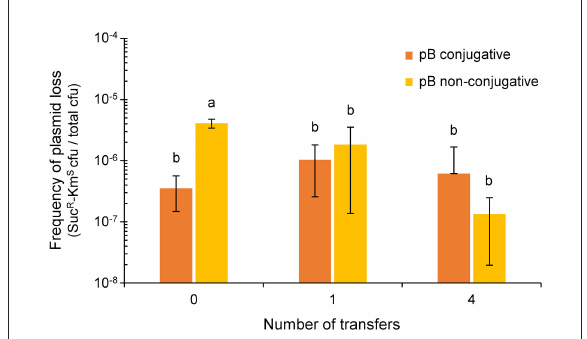
FIGURE3 Effect of the conjugative ability of pB (pPsv48B) on plasmid loss. Colored bars indicate the frequency of plasmid loss (mean ± sd), measured as the number of sucrose-resistant and kanamycin-sensitive colonies per total colony forming units in unsupplemented medium. The plasmidless strain P. syringae pv. savastanoi 1 ABC containing tagged derivatives of pB that were either conjugative (pB::Tn 5 -GDYN1, dark orange) or non-conjugative (pB[ virB4 ::Km- sacB ], light orange) were subcultured every 24h on solid medium MAM. Values are the average of at least three independent experiments, each with three replicates. Means with different letters are significantly different (one-way ANOVA and Duncan’s multiple range test; p <